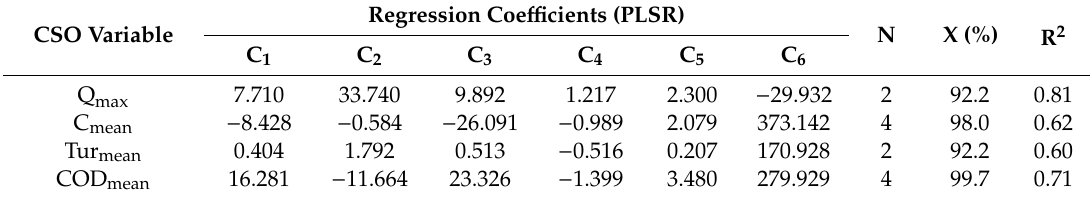
Table 5. Regression coe ffi cients for the prediction equations of the CSO variables as a function of the rainfall parameters for the El Vado CSO. R 2 is the coe ffi cient of determination of the PLSR.-N is the number of components used to build the PLSR model, and X is the percentage of variability explained by the